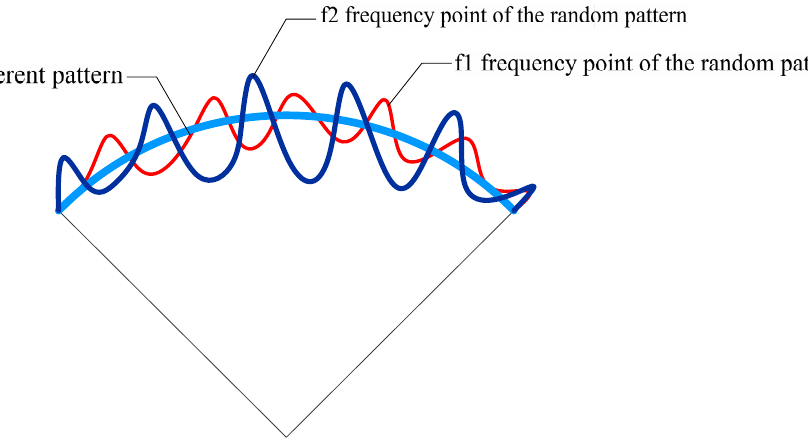
Figure 1. Comparison of coherent pattern of conventional antenna and random pattern of metamaterial antenna.